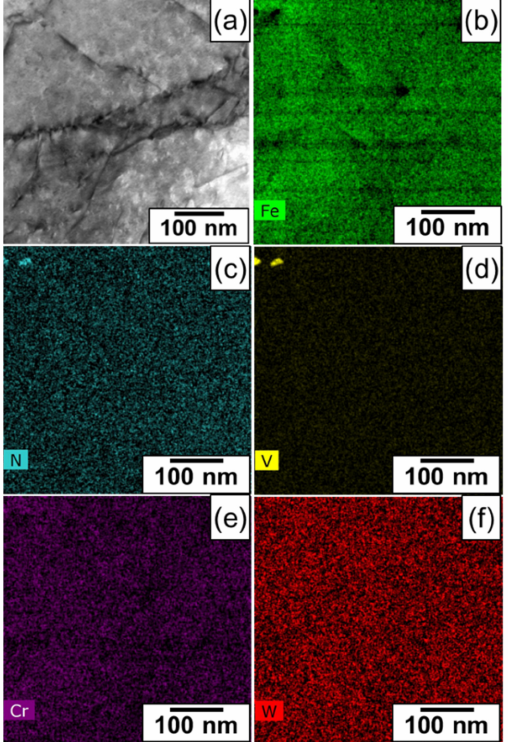
Figure 10. STEM micrograph ( a ) and associated EDS maps ( b – f ) at high magnifications of HT-1 exhibit a low density of fine MX